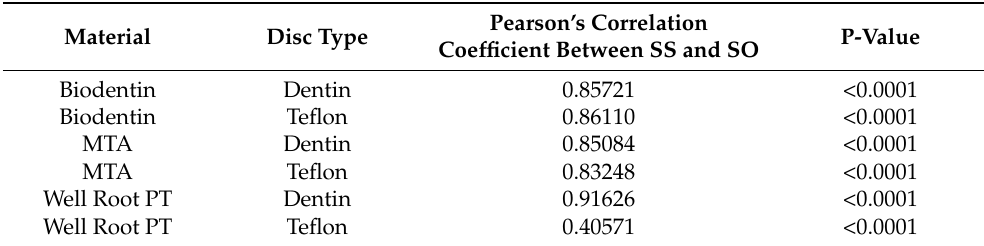
Table 5. Pearson’s correlation coefficient between mean values of central and peripheral zones (SS and SO) in three groups of materials and on both disc